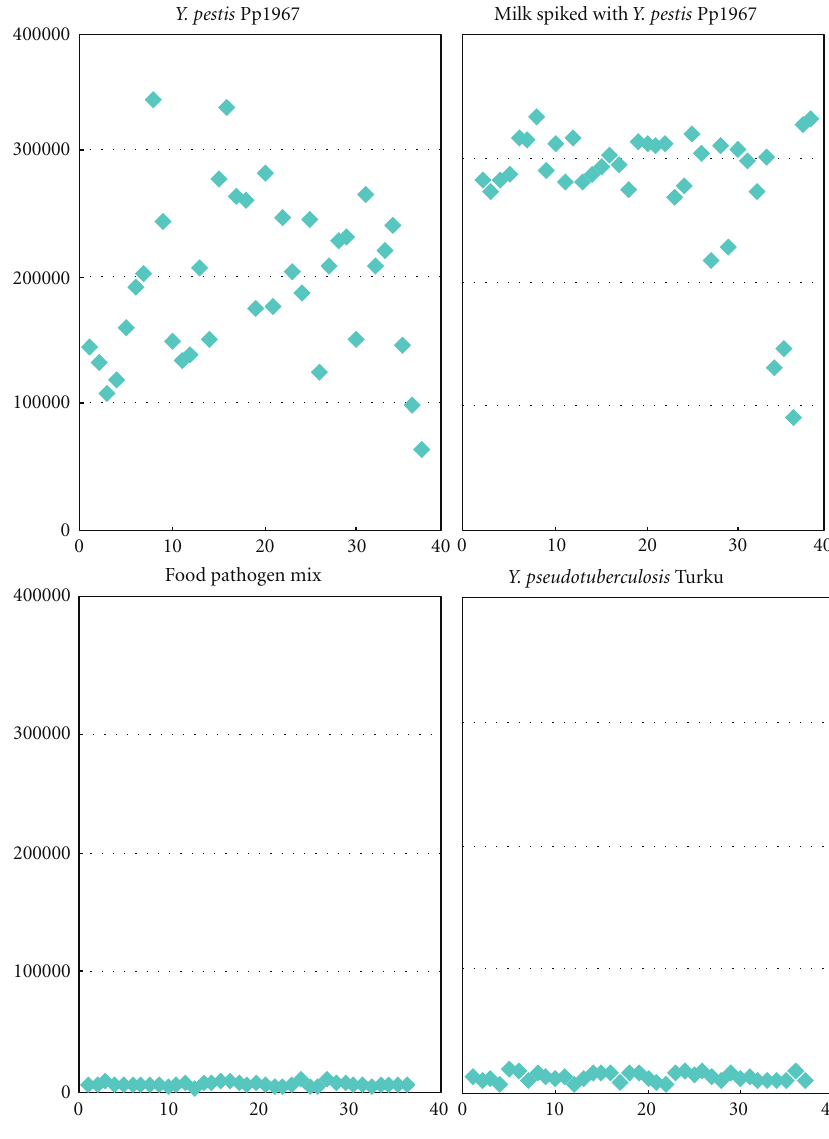
Figure 3: Total fluorescent intensity (TFI) of 37 Y. pestis -specific probes for amplified genomic DNA extracted from spiked milk samples. The X -axis numbers represent Y. pestis probe ID number. The Y -axis shows averaged TFI for each probe.